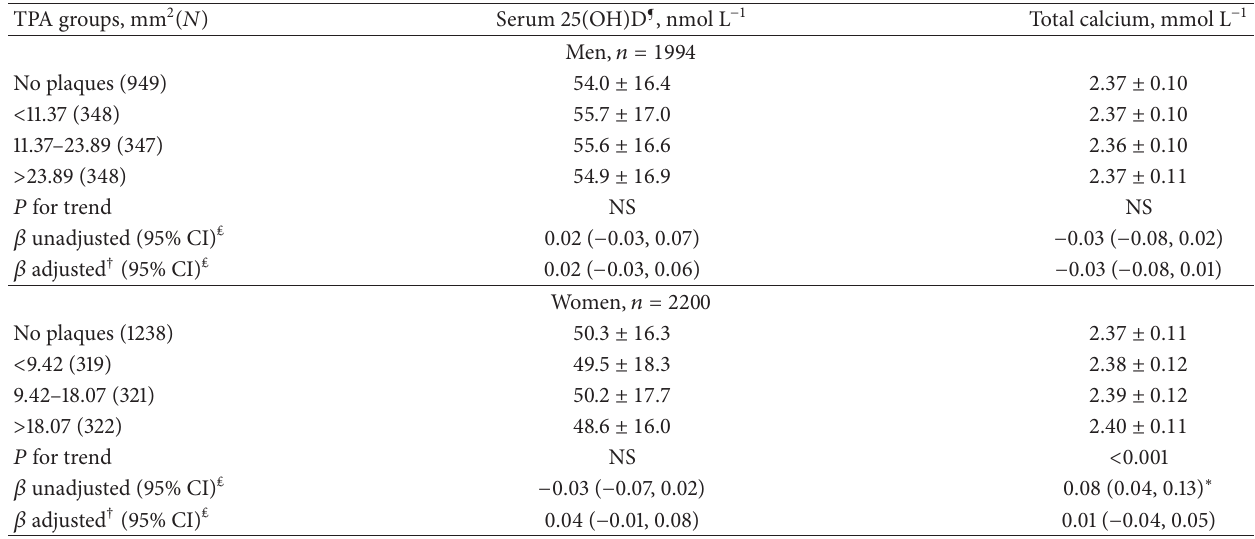
Table 3: Serum 25(OH)D (means ± SD) in the TPA groups in men and women and regression coefficients (𝛽) with their respective 95% confidential intervals from linear regression models. The 4th Tromsø Study,